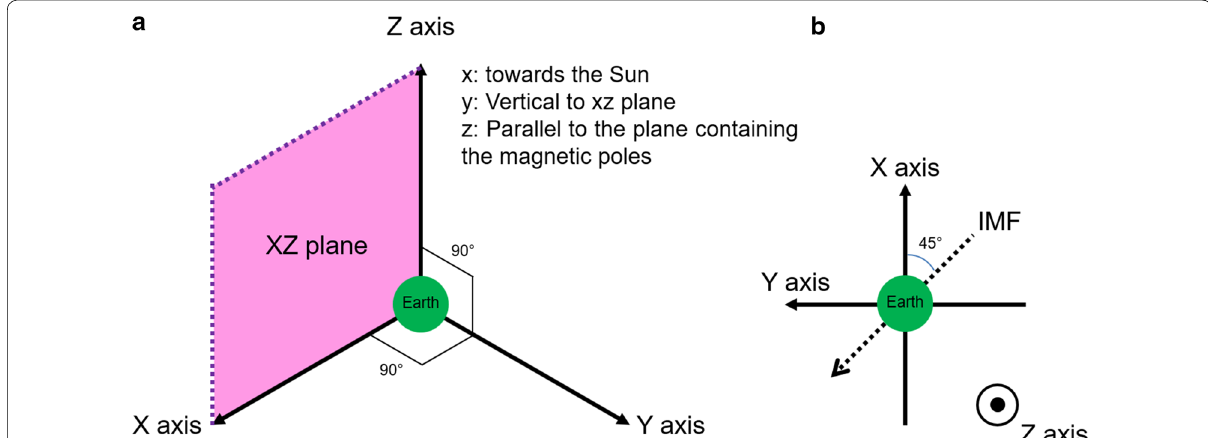
Fig. 5 The definition of orientation of each component of IMF. a The definition of geocentric solar magnetospheric (GSM) coordinate. The x axis is defined in the direction toward the Sun. The z axis is parallel to the plane containing the magnetic pole of the Earth. The y axis is vertical to the xz plane. b A view of the earth from the z axis direction. When viewed from the Earth, the IMF makes an angle of 45° with the x